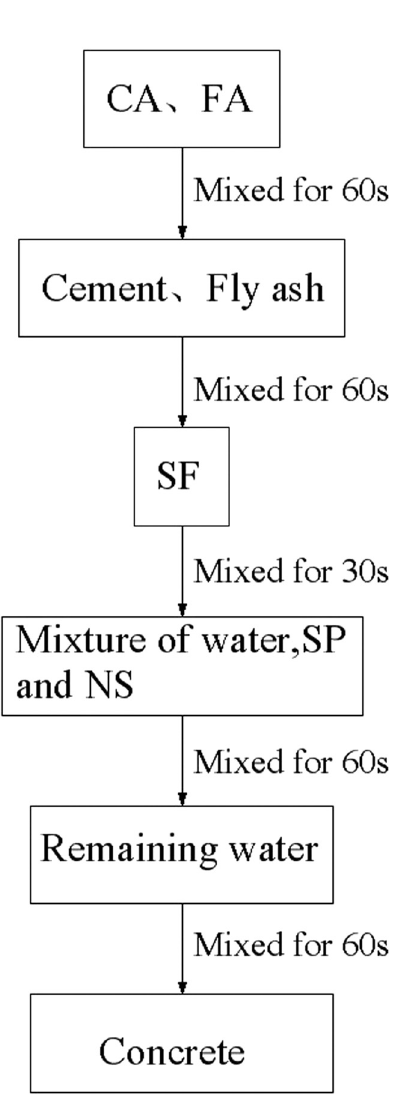
Figure 3: Mixing process of